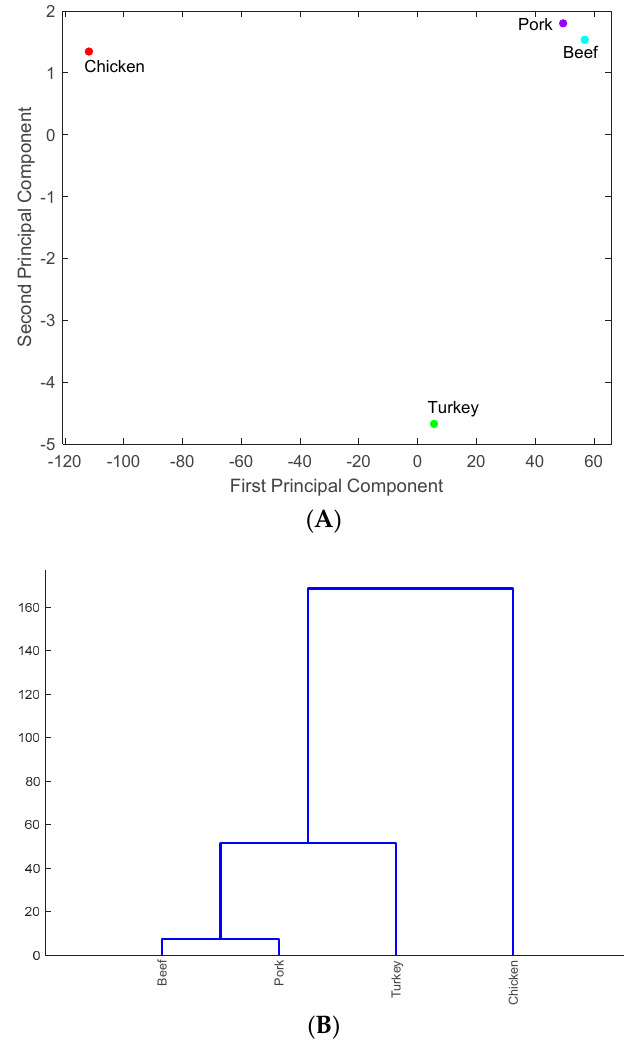
Figure 6. The representation of the meats that carry antimicrobial-resistance genes in the PC1–PC2 space ( A ) and in the hierarchical clusters ( B ) for Pennsylvania.